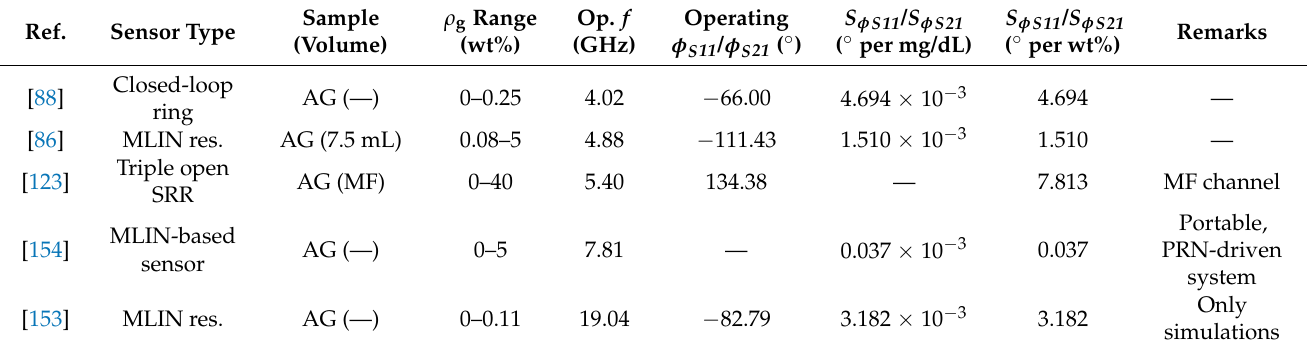
Table 4. Phase-based sensors. AG = aqueous glucose solutions; MLIN = microstrip line; PRN = Pseudo random noise.